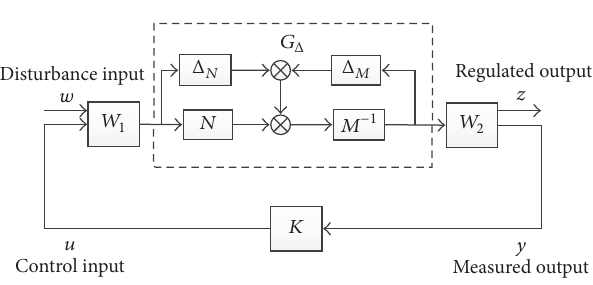
Figure 3: The Glover-McFarlane 𝐻 ∞ loop shaping